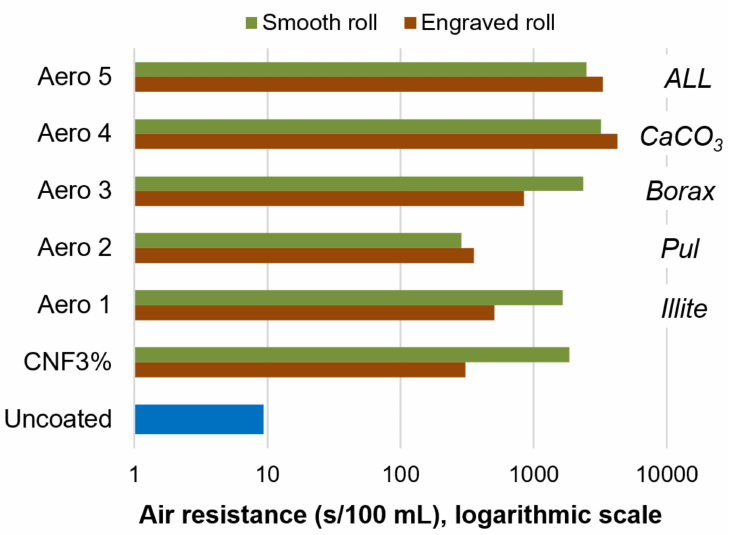
Figure 5. Air resistance (Gurley method) for uncoated paper, nanocellulose-coated paper, and sheets that were coated with formulations Aero 1–5 .